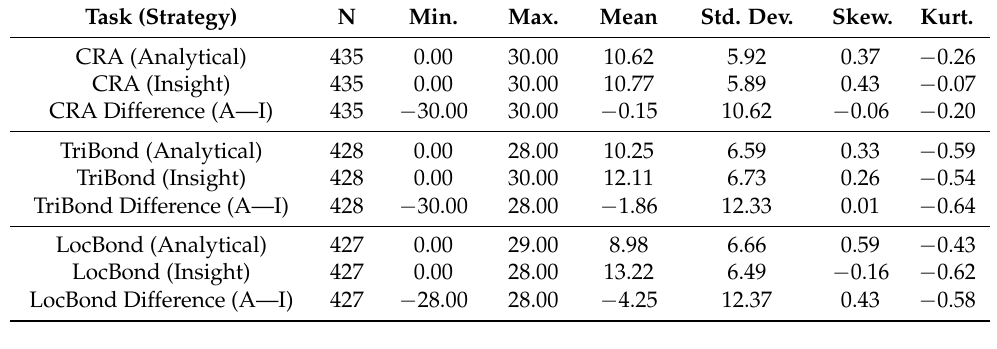
Table 5. Descriptive statistics for each multiply-constrained problem-solving task (compound remote